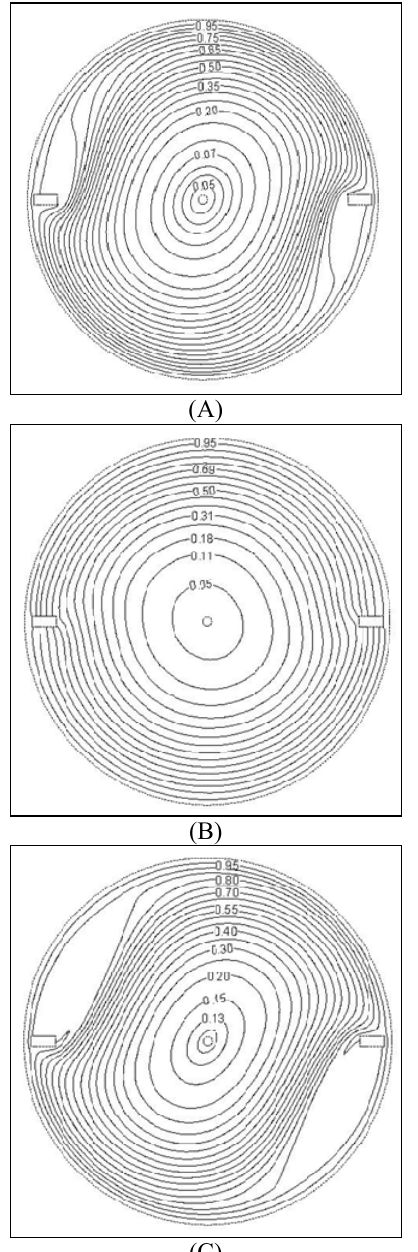
Fig. 8. Isotherms lines (a): Re=0.7, (b): Re=13.8, (c): Re=415 for Pr=7